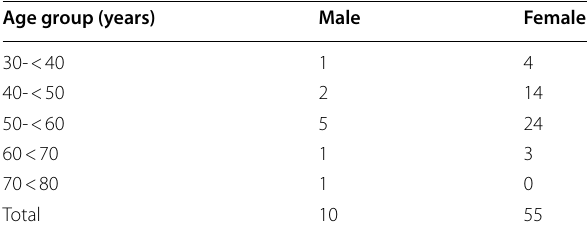
Table 1 age and sex distribution of this study